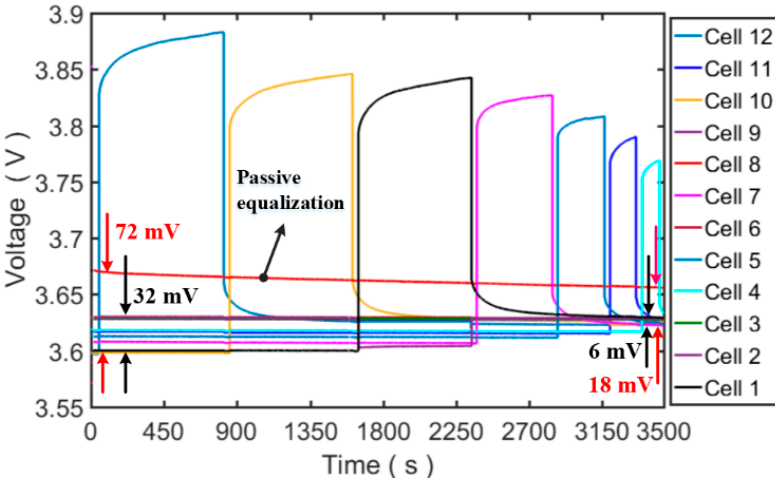
Figure 14. Experimental result under static condition.